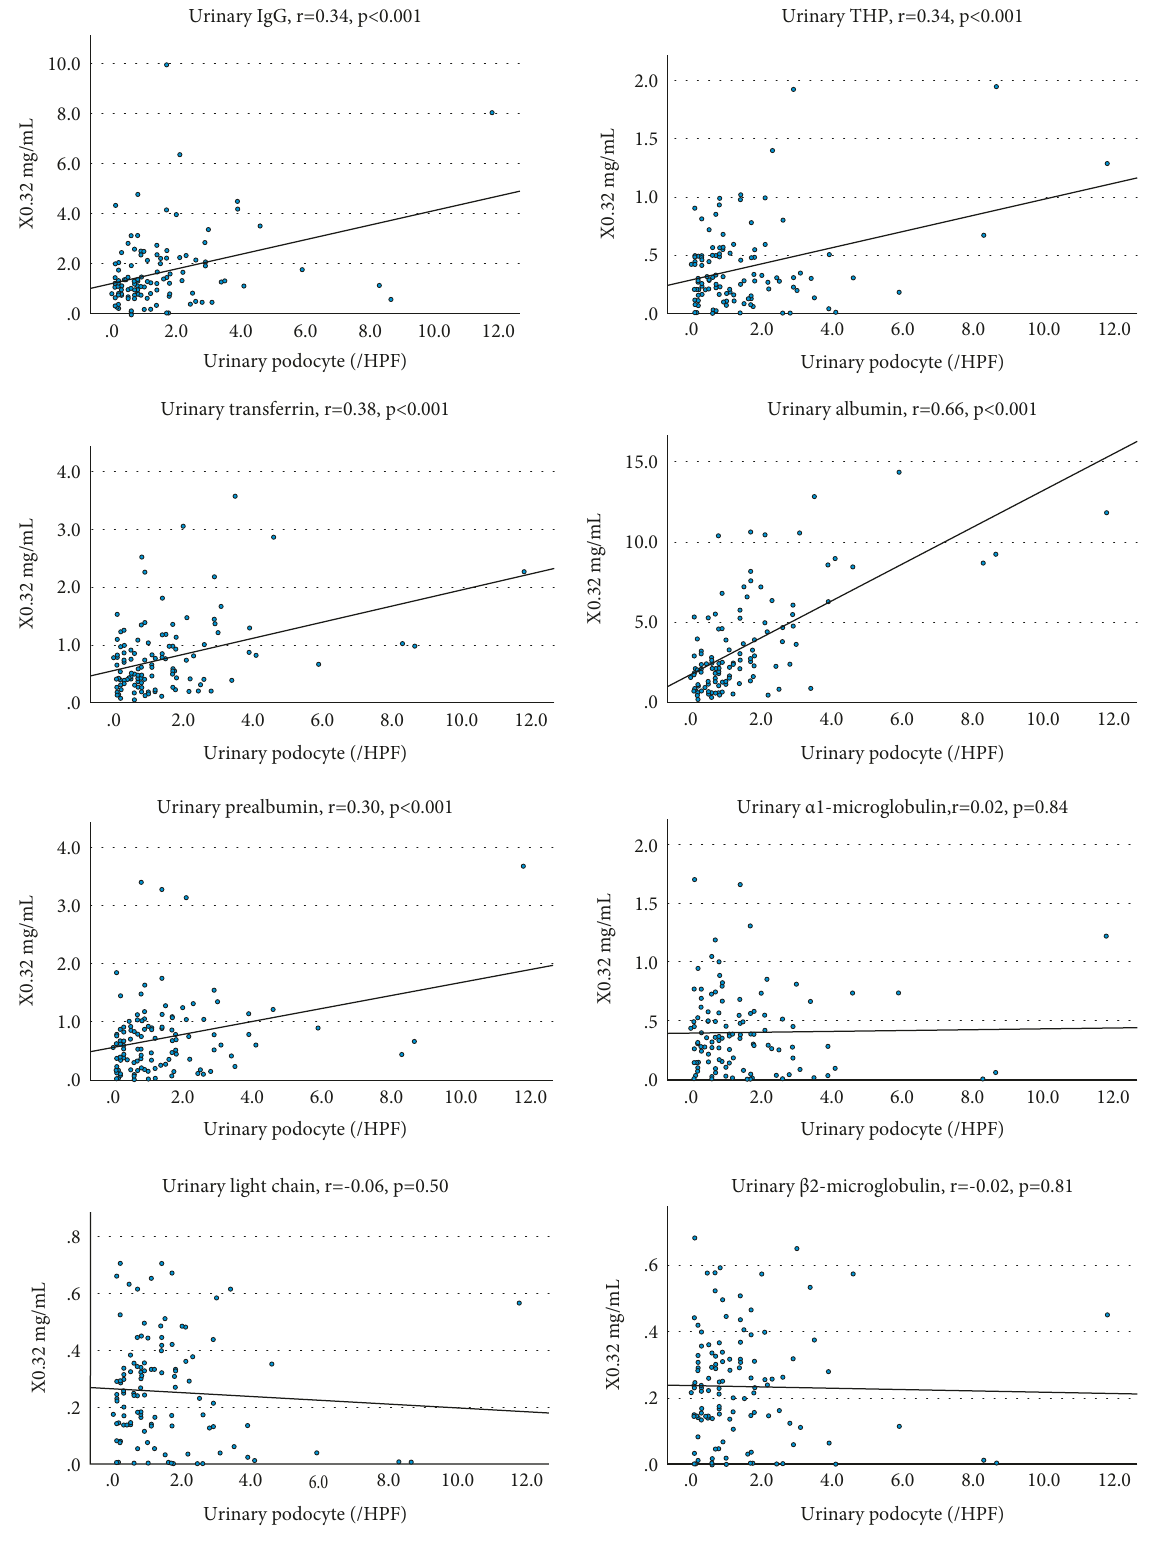
Figure 3: The correlation between urinary podocyte excretion and urinary protein fractions. The r and p values were as follows: urinary podocytes and IgG, r � 0.34, p < 0 . 001; Tamm–Horsfall protein (THP), r � 0.34, p < 0 . 001; transferrin (Tf), r � 0.38, p < 0 . 001; albumin, r � 0.66, p < 0 . 001; prealbumin, r � 0.30, p < 0 . 001; α 1-microglobulin, r � 0.02, p � 0 . 84; light chain (LC), r � − 0.06, p � 0 . 50; and β 2- microglobulin, r � − 0.02, p � 0 . 81 ( n �